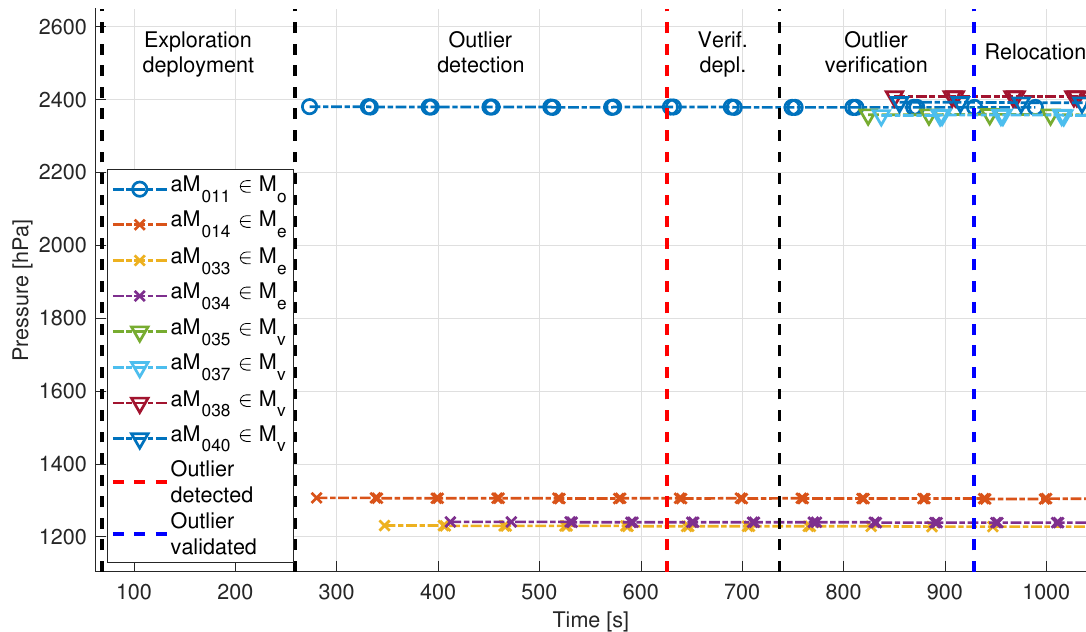
Figure 19. Pressure data exchanged via acoustic communication during the Biograd na Moru experiment. aMussel 11 is the outlier and was successfully verified as such.